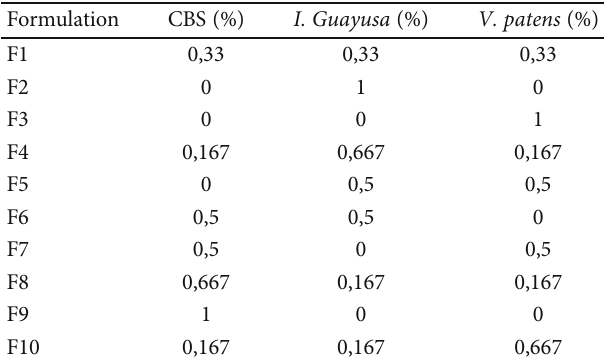
Table 1: Coded values of the herbal formulations prepared with cocoa bean shell (CBS), I. guayusa and V. patens .